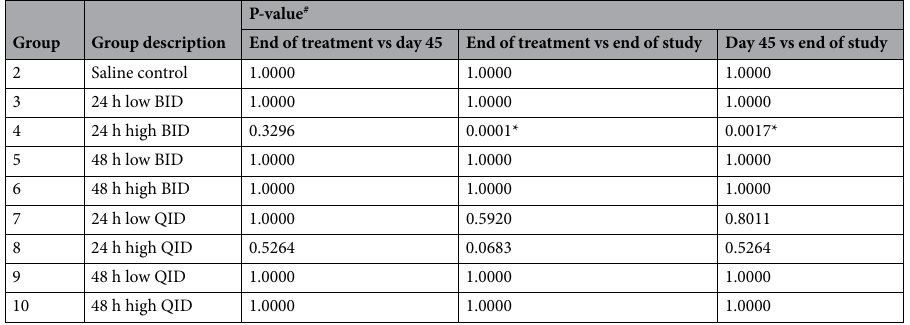
Bacterial tissue burden of ceftazidime treated mice. Bacterial burdens in the kidney, liver, lung, and spleen were assessed in all mice that succumbed to disease or were humanely euthanized to verify presence and quantity of B. pseudomallei (Fig. 3, supplemental data Tables S5–S8). The mean bacterial load of only the 48 h low QID dose group, in which all measurements were negative, was significantly less than that of the saline group for the kidney (p = 0.0127). The mean bacterial loads of all treated groups were significantly less than that of the saline control group for the liver (p values ranged from < 0.0001 to 0.0024). The mean bacterial loads of the 24 h QID dose groups were significantly less than that of the saline control group for the lung and spleen (p ≤ 0.0001). Furthermore, the mean bacterial load of the 24 h high dose BID group was significantly less than that of the saline control group for the lung (p = 0.0001), and the mean bacterial loads of the low BID dose groups and the 48 h high dose QID group were significantly less than that of the saline control group for spleen (p values ranged from < 0.0001 to 0.0373).